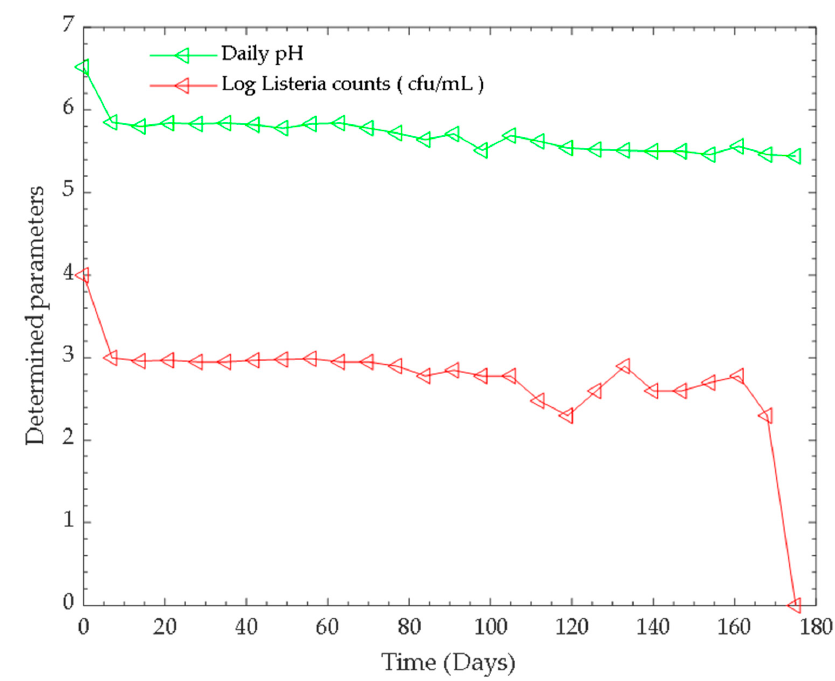
Figure 1. Log bacterial counts and daily pH over time.